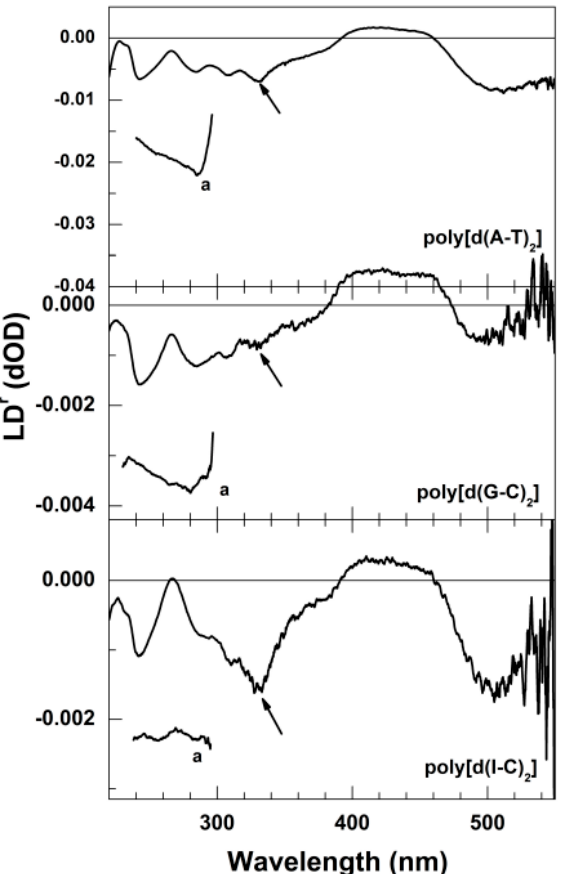
Figure 3. LD r spectra of of bis ‐ Ru ‐ bpp bound to poly[d(A ‐ T) 2 ], poly[d(G ‐ C) 2 ], and poly[d(I ‐ C) 2 ]. Symbol a denotes LD r spectra of corresponding polynucleotides in the absence of the bis ‐ Ru ‐ bpp complex. The concentration is the same in Figure 1. The absorption band ca . 330 nm, corresponding to the electronic transition moment lies along the long axis of the dppz ligand, is marked by arrows.